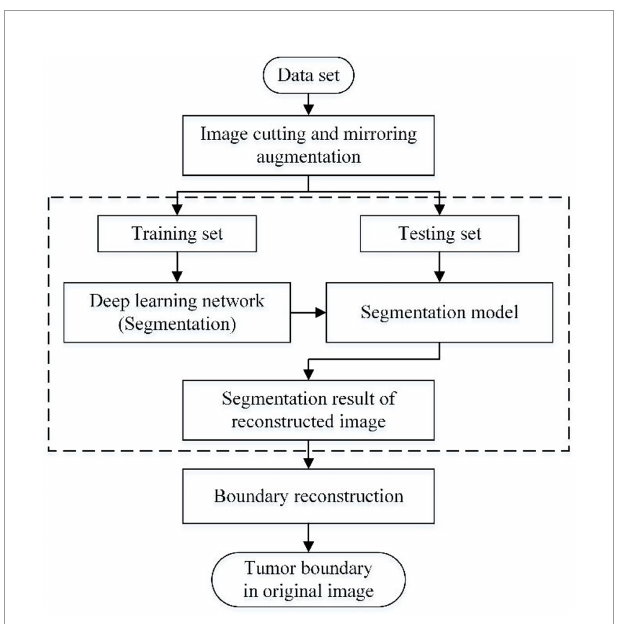
FIGURE 1 | Flowchart of this method.